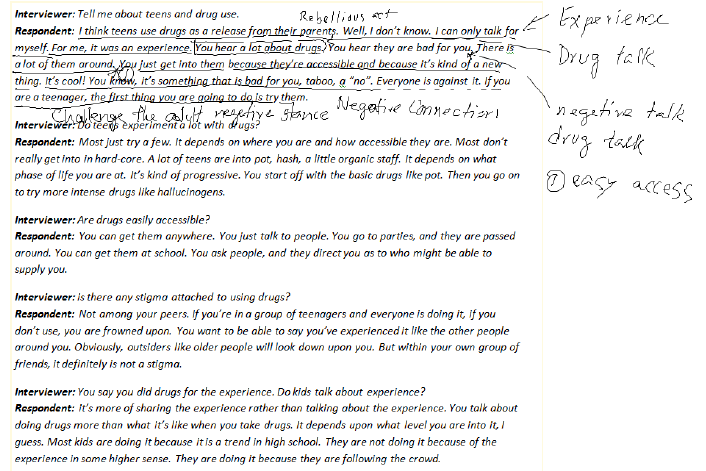
Figure 4: Open coding with pen and